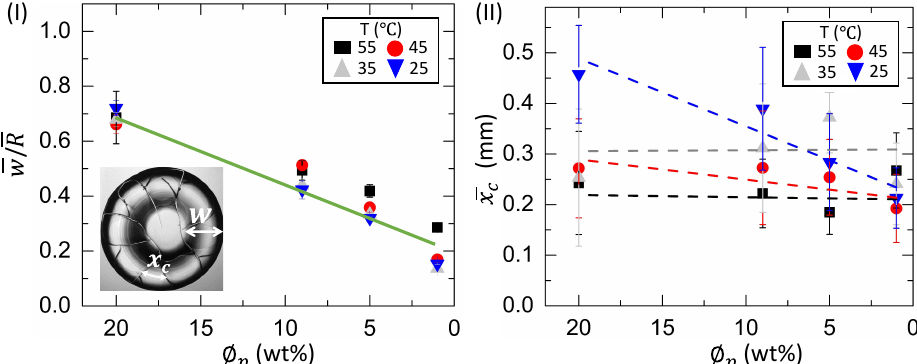
Figure 13. ( I ) Concentration dependence of the normalized width of the ring ( w / R ) of the BSA film at different substrate temperatures (T) from 55 to 25 ◦ C. The green solid line shows a master linear fit. ( II ) Concentration dependence of the averaged crack spacing ( x c ) of the BSA film at different T from 55 to 25 ◦ C. The different colored dashed lines at different temperatures are drawn to guide our eyes. The x c and w are shown on the dried BSA film at φ p of 20 wt% and T = 25 ◦